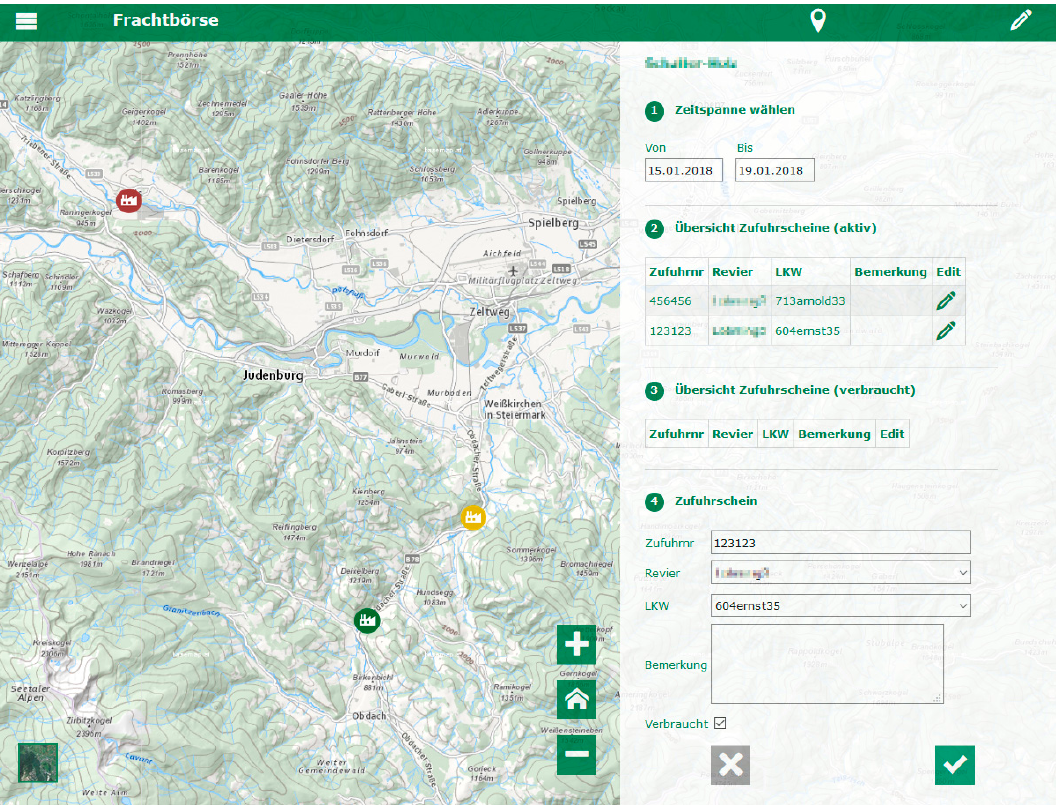
Figure 9. The “Freight exchange app” showing active and consumed delivery notes for different customers (sawmills).